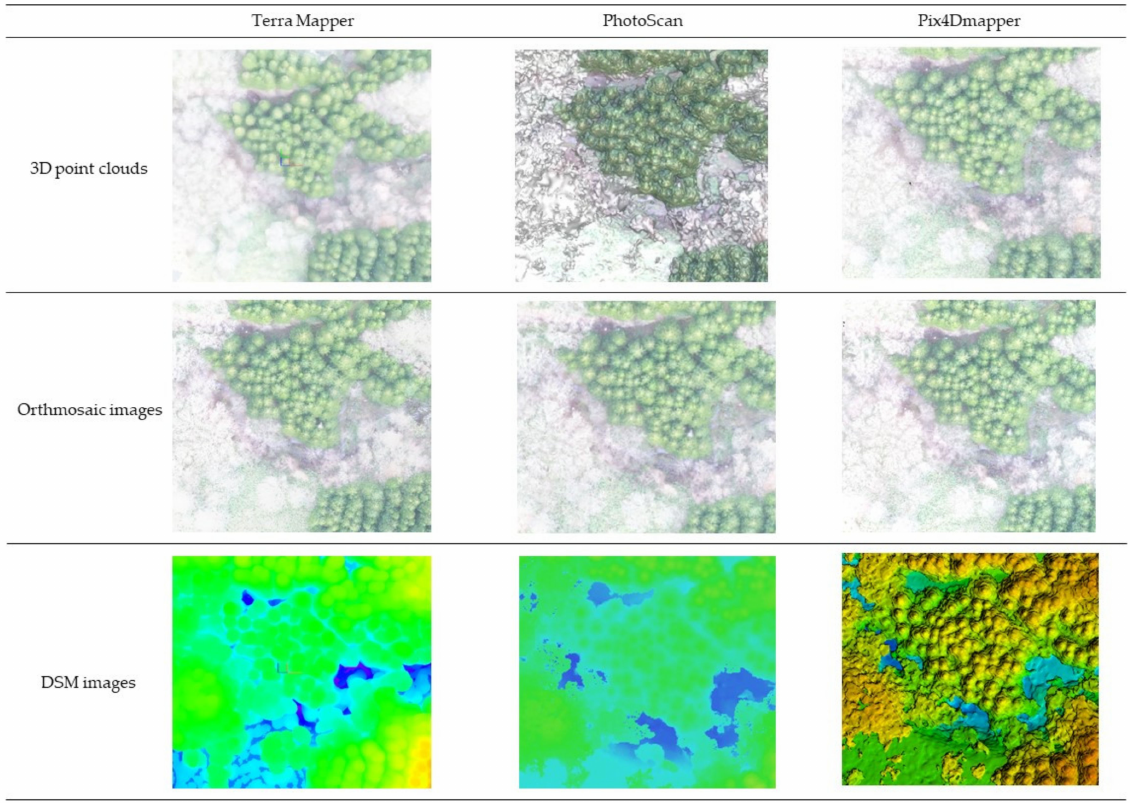
Figure 6. Example of the 3D point clouds, orthomosaic images, and DSM images generated by each SfM